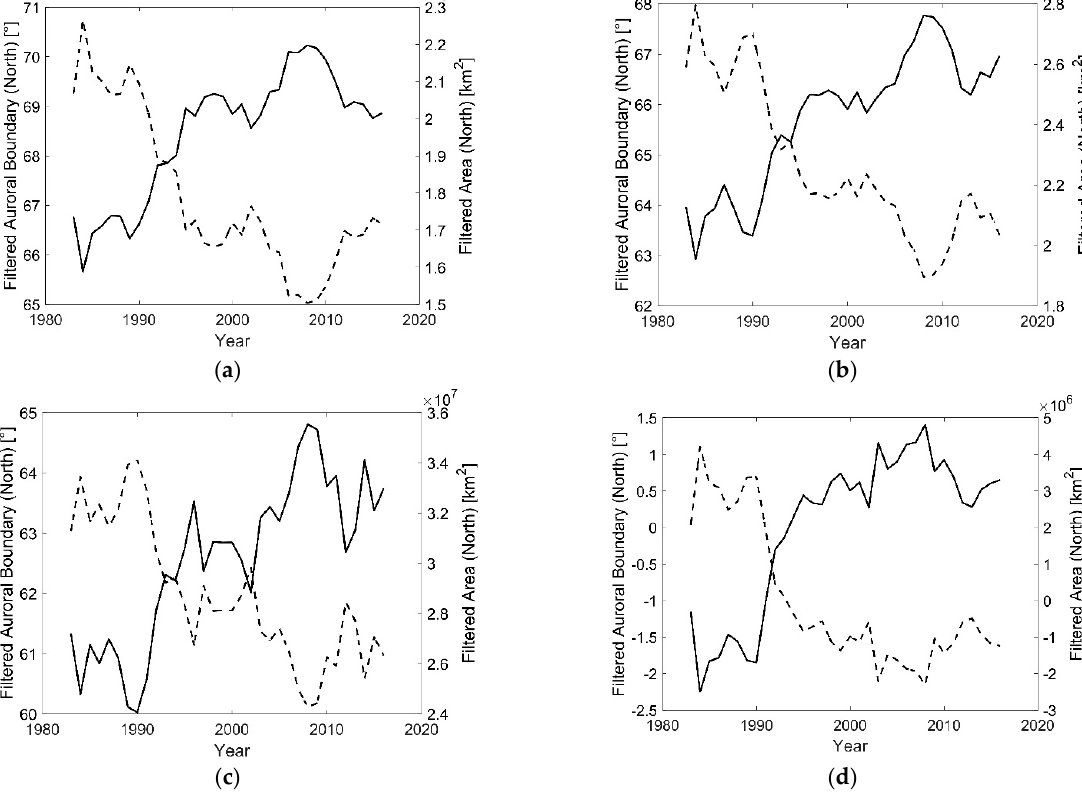
Figure 5. Northern hemisphere filtered AB (°) time variation considering data with QC = 1 and 2 (solid lines) and corresponding auroral outer boundary enclosed area A (km 2 ) (dashed lines) using the following filters for AB and A: data for 0 < Kp ≤ 2 ( a ), 2 < Kp ≤ 4 ( b ), 4 < Kp ≤ 6 ( c ), and annual means of residuals from the linear regression with Kp ( d ). Note the different scales.